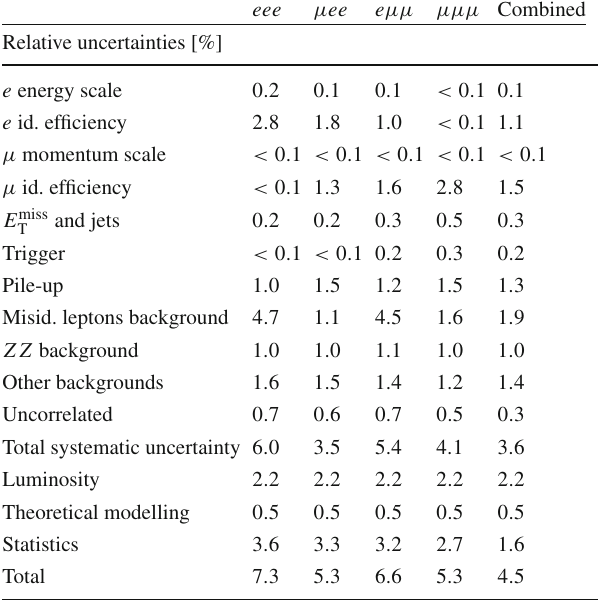
Table3 Summaryoftherelativeuncertaintiesonthemeasuredfiducial cross section σ fid. for each channel and for their combination. The W ± Z uncertainties are reported as percentages. The first rows indicate the main sources of systematic uncertainty for each channel and their com- bination, which are treated as correlated between channels. A row with uncorrelated uncertainties follows, which comprise all uncertainties of statistical origin including MC statistics as well as statistical uncer- tainties in the fake-factors calculation, which are uncorrelated between channels